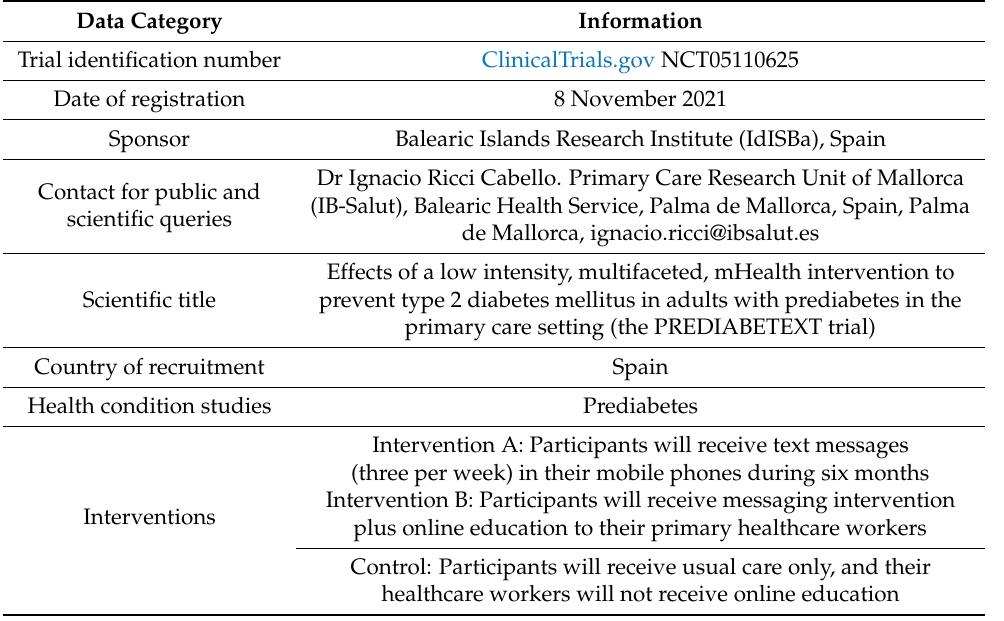
Table 1. Brief structured summary of the